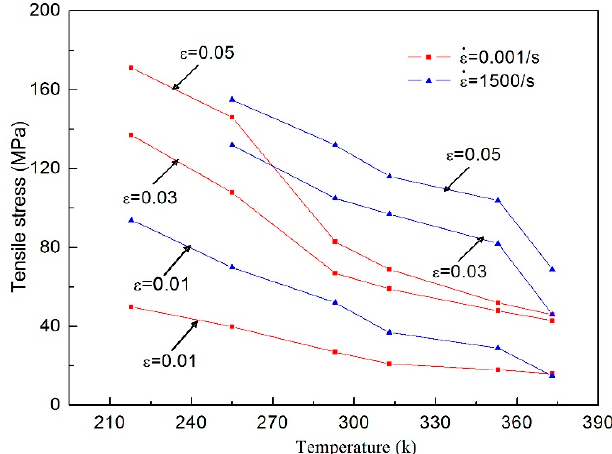
Figure 15. Variation relation of tensile stress with temperature at different strain levels.